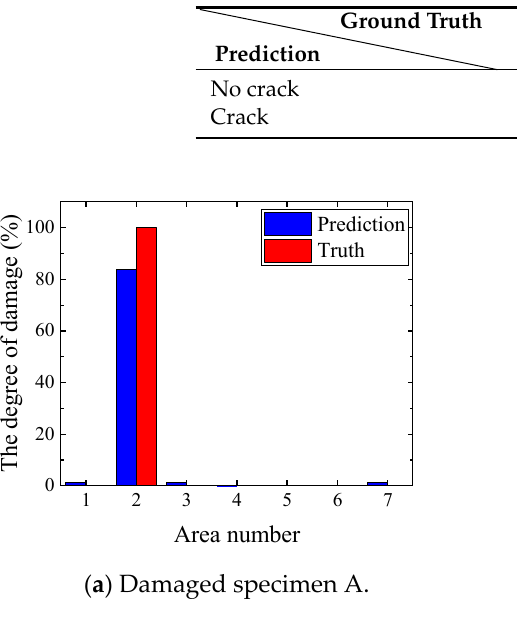
Table 4. Crack detection results (actual specimens).